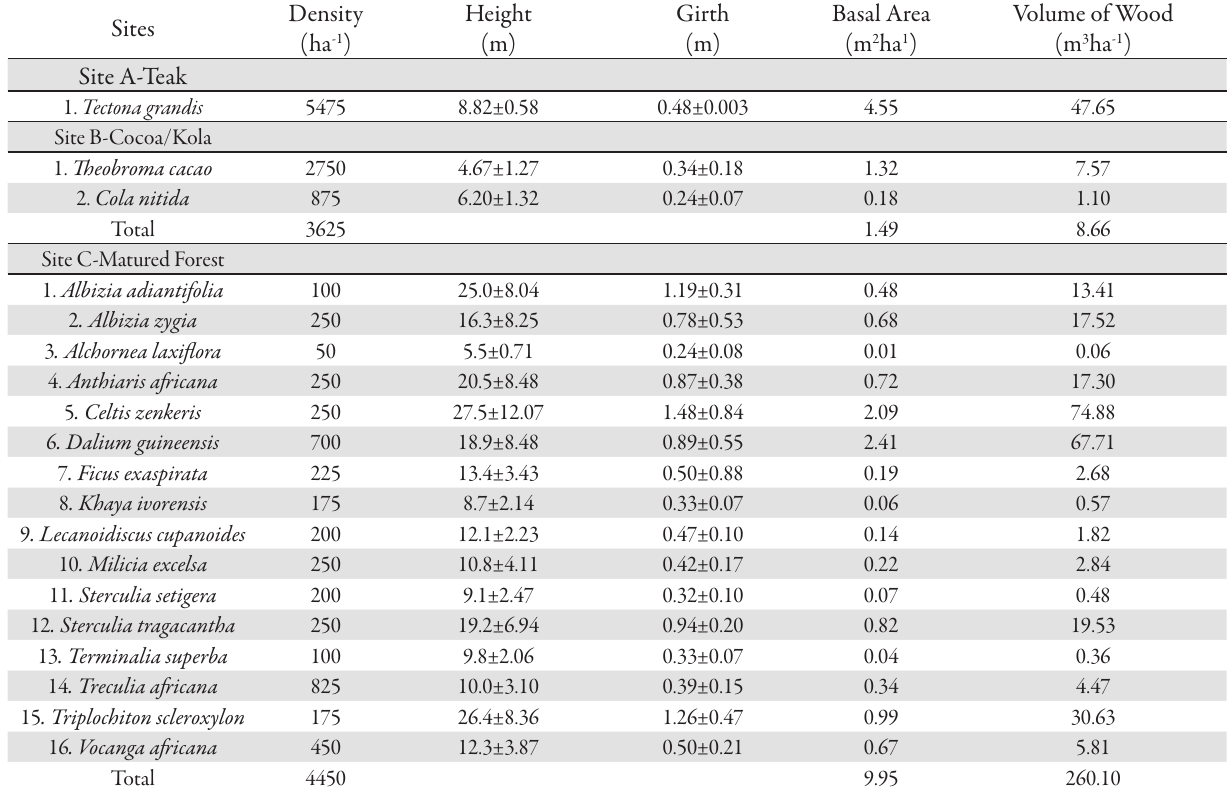
Tab. 1. Biomass characteristics of the woody species in the study sites Sites